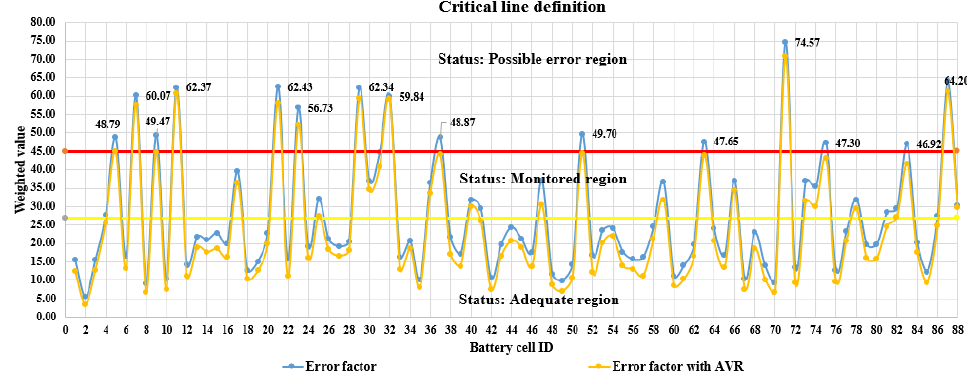
Figure 13. Aggregate error factor assigned to the cell ID.